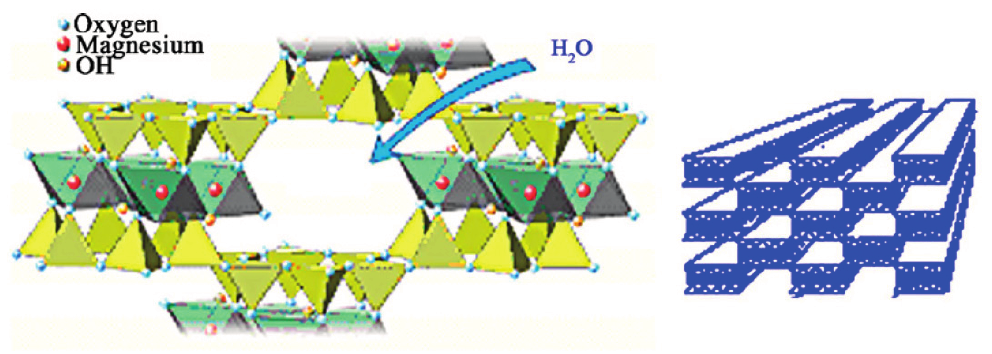
Figure 3. Structure of hydrated natural sepiolite.